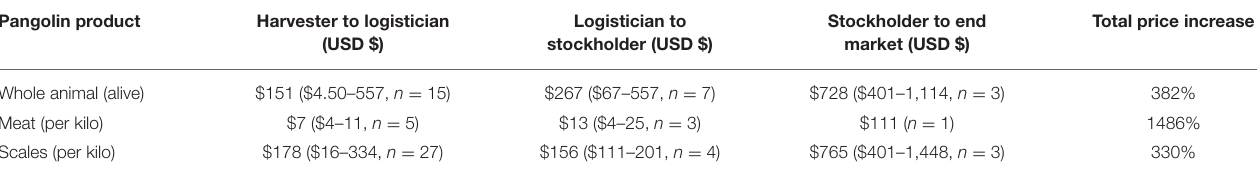
TABLE 3 | Mean price (and range) for pangolin parts and products across trade actors from 2011–2019. Pangolin product Harvester to logistician